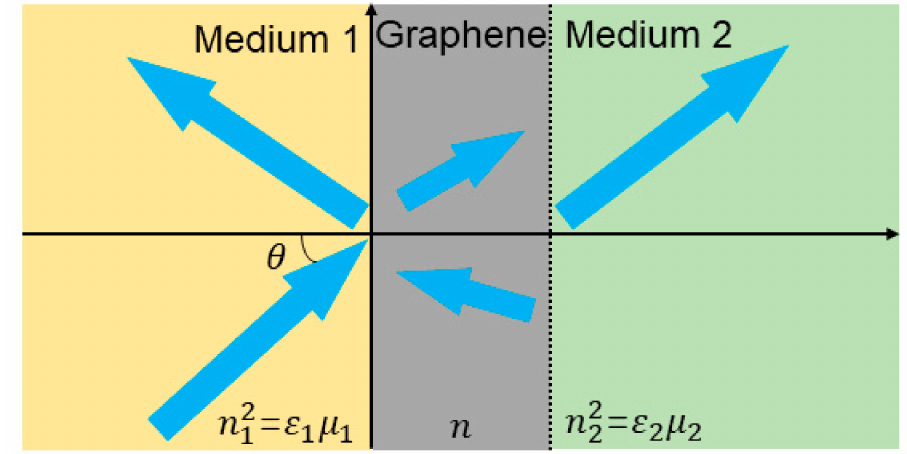
Figure 1. Schematic of a graphene layer sandwiched between two dielectrics (RI, n1 >